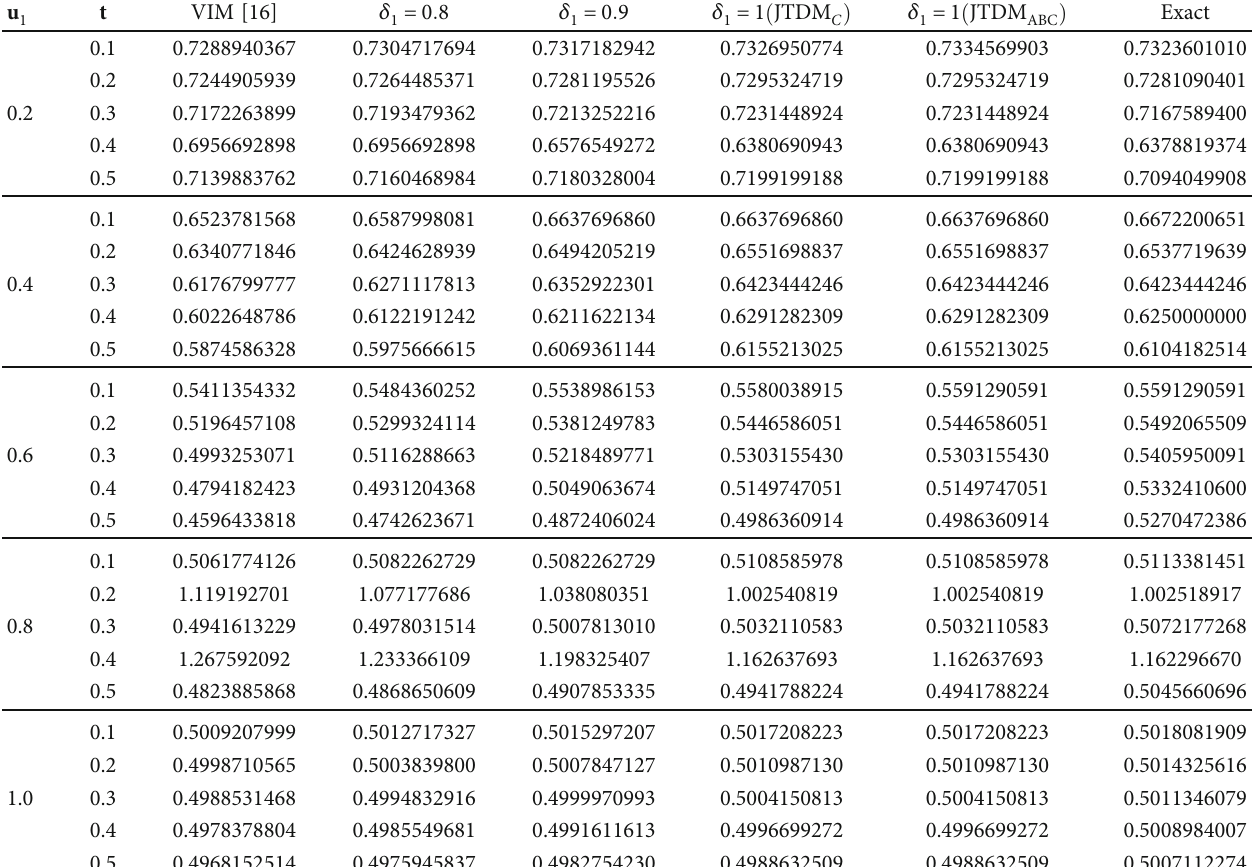
Table 1: The exact, JTDM of u 1 and t when u 2 = 0 : 5 and Re = 75